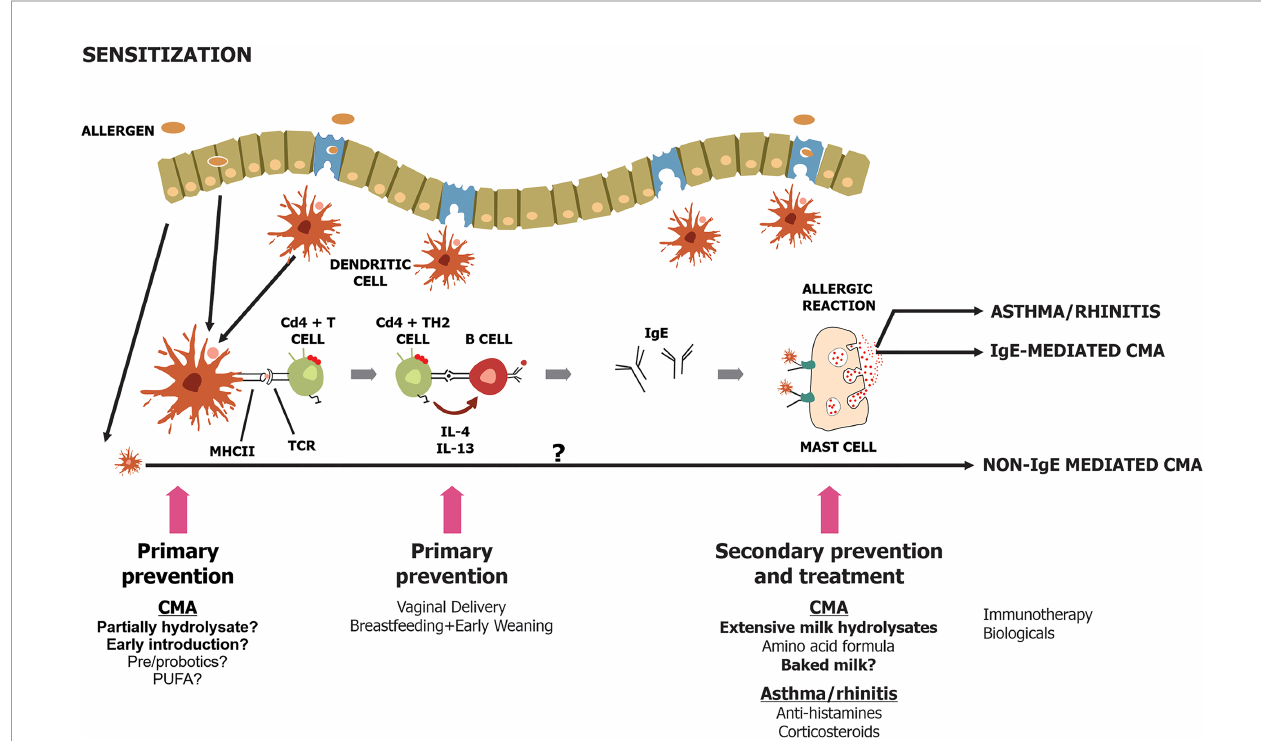
FIGURE 1 | Schematic diagram on primary, secondary and tertiary prevention [adapted from